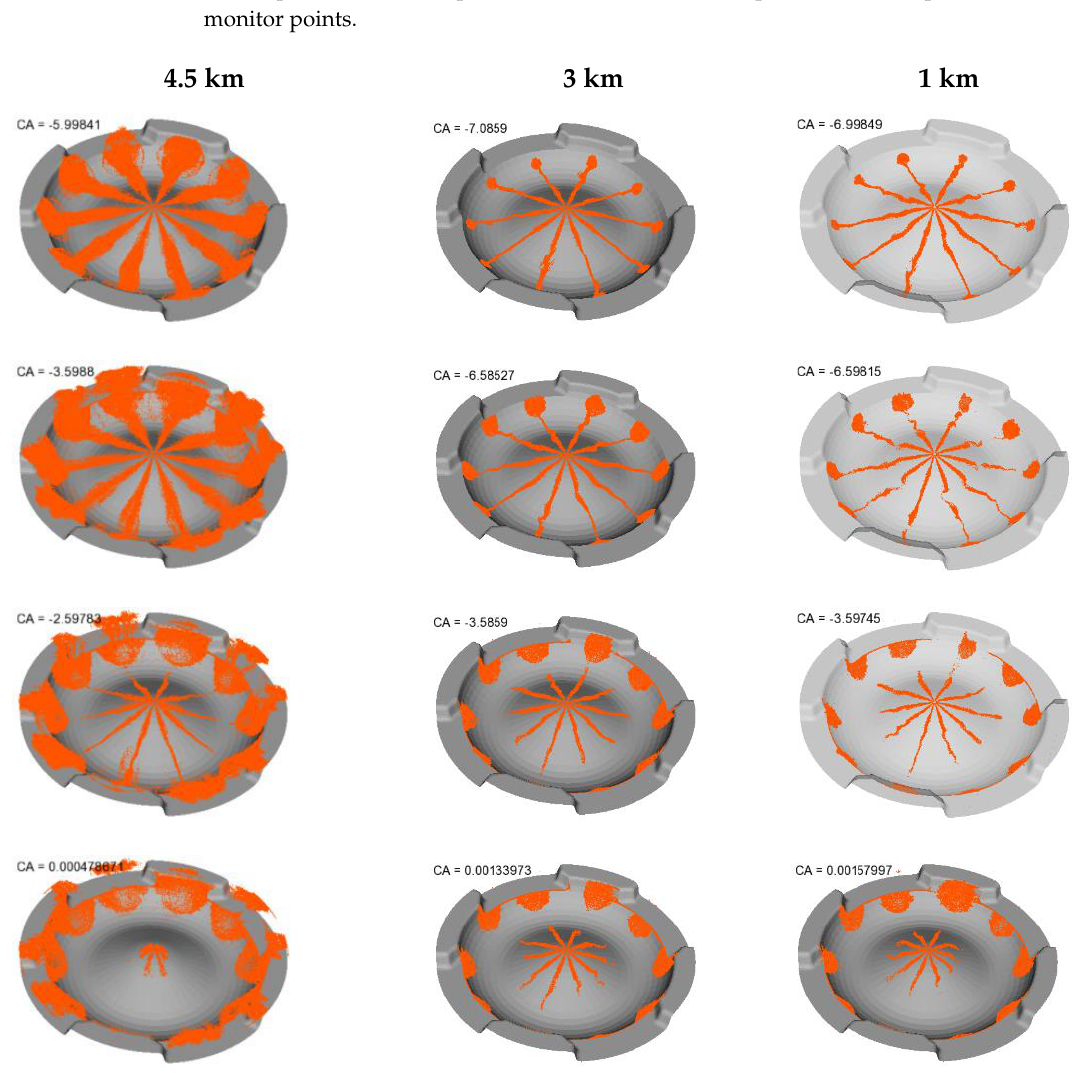
Figure 15. Comparison of spray distribution (liquid phase) at various altitudes.